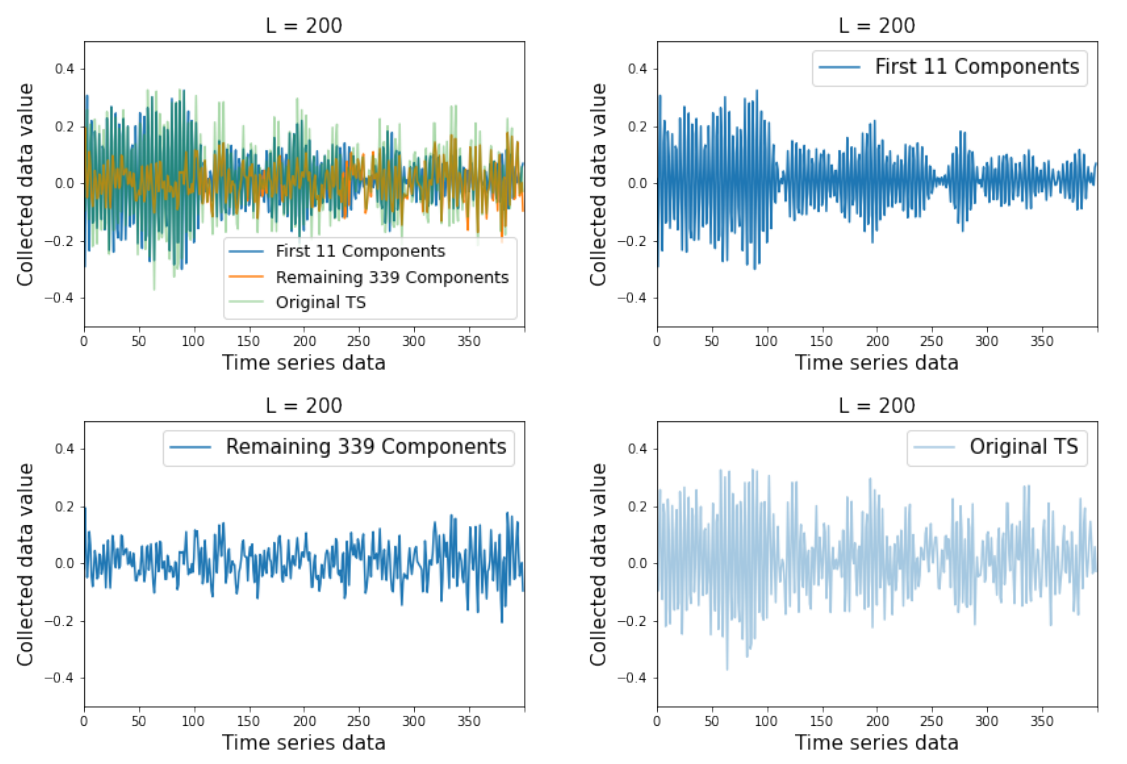
Figure 10. Figure shows how SSA decomposes noise-mixed data. The top right, it shows the first 11 elements, the bottom left—maintaining 339 components, and the bottom right—the original time series (TS), and the top left shows mixture of components.